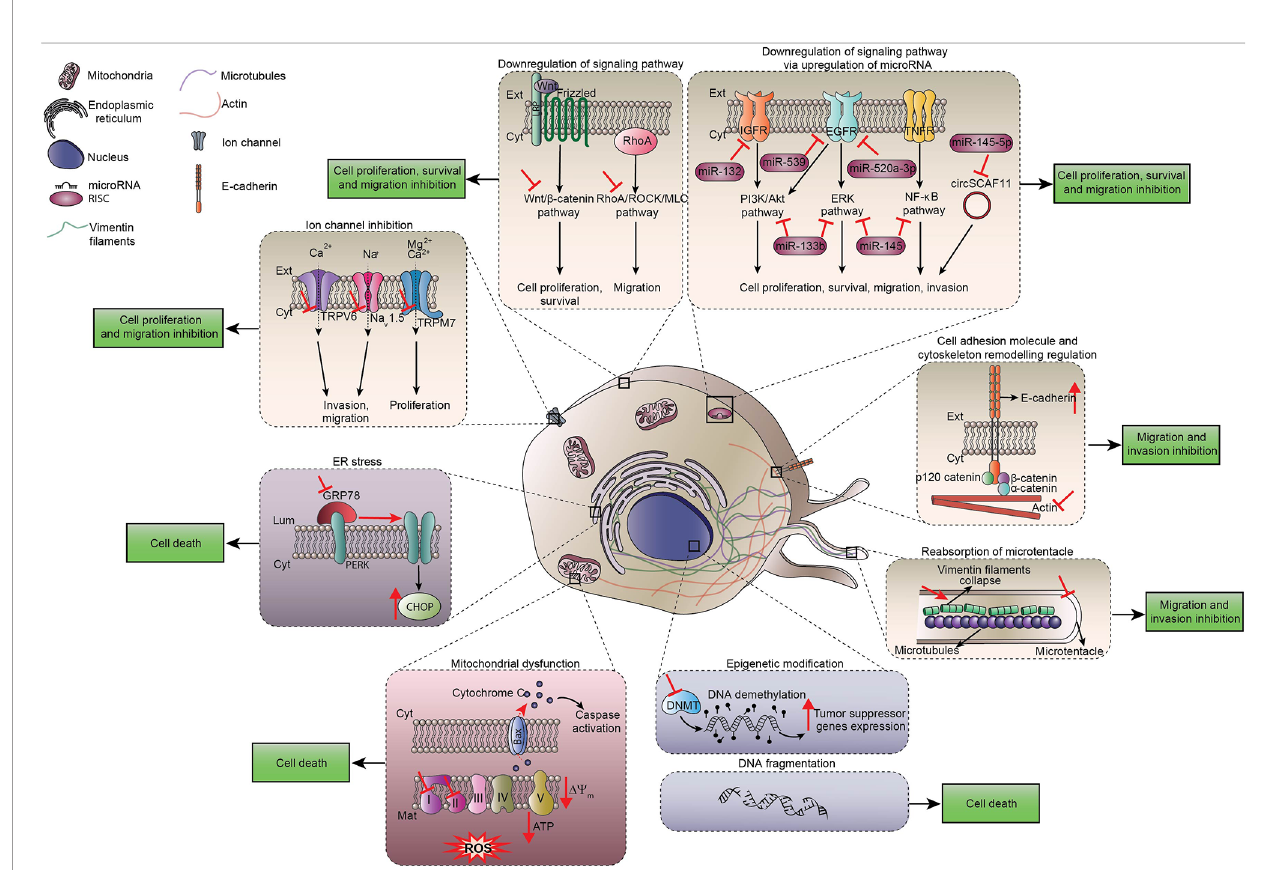
FIGURE 1 | Direct cytotoxic effects of local anesthetics. Scheme summarizing direct effects of local anesthetics on cancer cells including the regulation of signaling pathways that control proliferation, survival and migration of cancer cells. Ca2+, calcium ion; CHOP, C/EBP Homologous protein; Cyt, Cytoplasm; DNMT, DNA methyltransferase; EGFR, epidermal growth factor receptor; ER, endoplasmic reticulum; Ext, extracellular space; IGFR, insulin growth factor receptor; Mg2+, magnesium ion; Na+, sodium ion; TNFR, tumor necrosis factor receptor; ROS, reactive oxygen species; PERK, protein kinase R-like ER